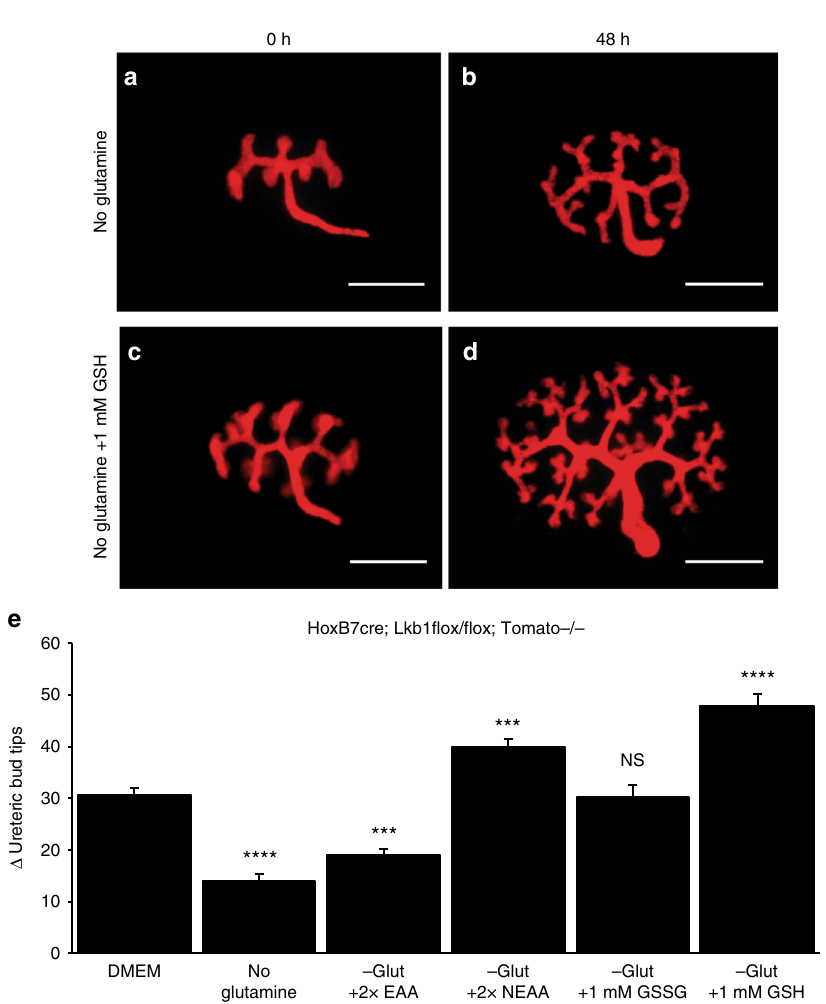
Fig. 4 Exogenous sources of amino acids or glutathione rescues growth defect of Lkb1 mutant cells in the absence of glutamine. Live images of e12.5 HoxB7-Cre; Lkb1 fl ox/ fl ox ; RosaTomato kidneys after 0 ( a , c ) or 48 ( b , d ) hours of culture in glutamine-de fi cient media ( a , b ) or glutamine-de fi cient media supplemented with 1 m M GSH ( c , d ). e Quanti fi cation of the change ( Δ ) in branch number (number of ureteric bud tips after 48 h — ureteric bud tips at 0 h) for e12.5 HoxB7-Cre;Lkb1 fl ox/ fl ox ; RosaTomato kidneys grown in DMEM, DMEM-glutamine, DMEM-glutamine + 2× essential amino acids, DMEM- glutamine + 2× non-essential amino acids, DMEM-glutamine + 1 m M oxidized glutathione (GSSG), or DMEM-glutamine + 1 m M reduced glutathione